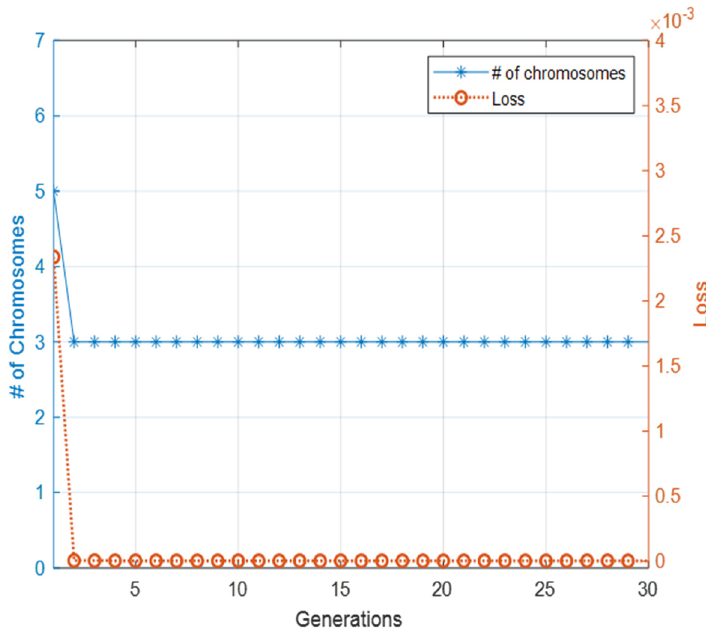
Figure 6. Evolution process of English grammaticality task.